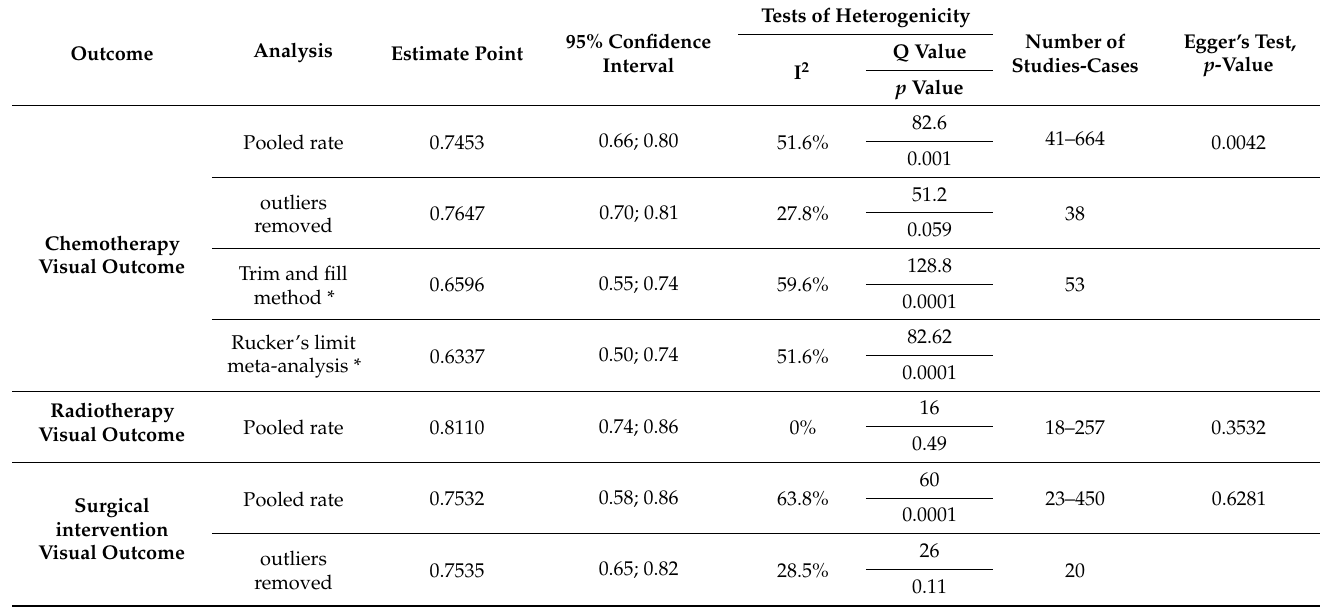
Table 4. The results of the meta-analysis, performed on the visual outcomes of the OPG